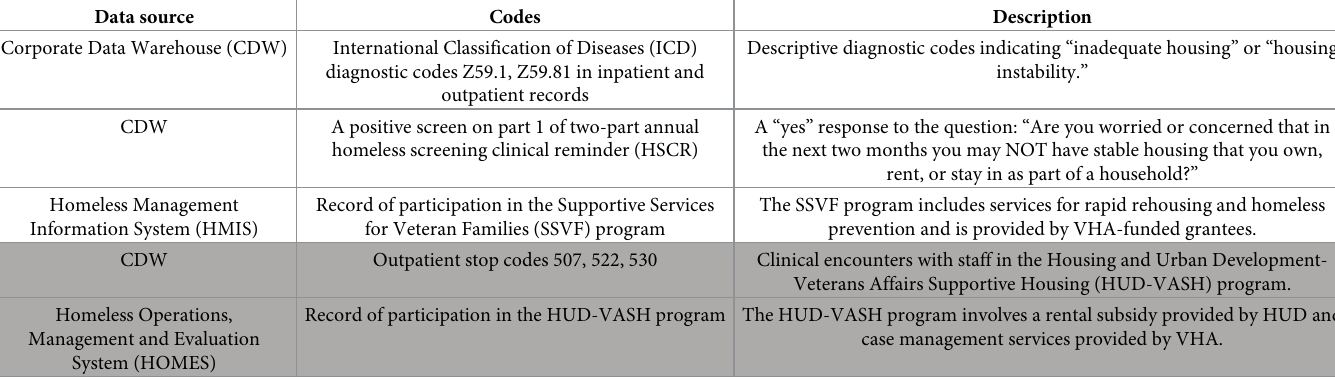
Table 1. Data source, codes, and descriptions for defining housing instability in Veterans Health Administration medical records.